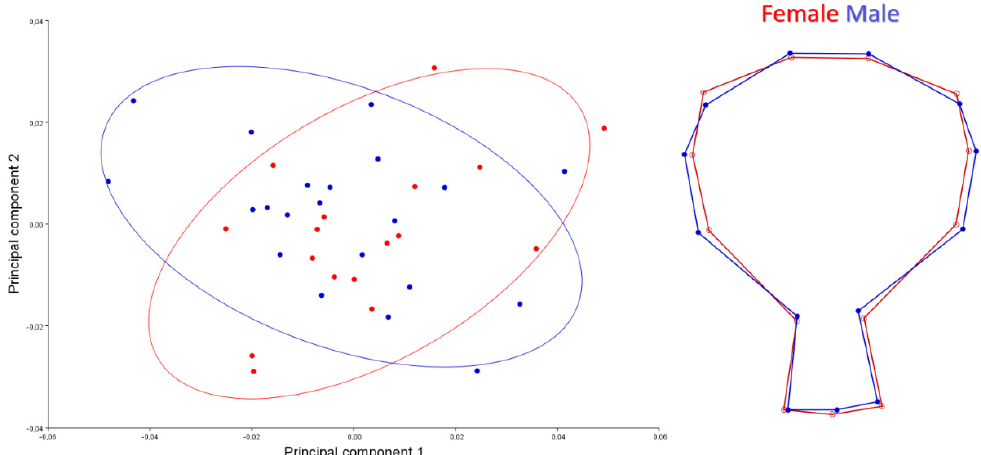
Figure 4. Scatter plot of PC1 (41.206) and PC2 (34.246) of quails for caudal view ( left ). Wire-frame warp plots of changes in the cranial shape of quail, as mapped by 8 landmarks ( right ). A scatter plot for ventral is given in Figure 5. PC1-2 explained 57.17% of the total variation. Skulls of male samples showed wider shape change than females skulls samples. In ventral view, it was seen that male individuals had a bit wider skull in shape.